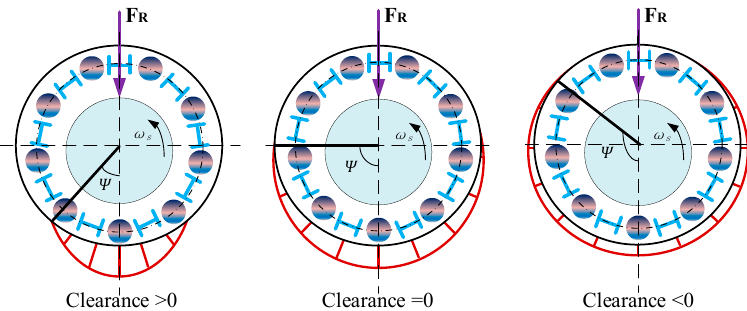
Figure 2. Rolling element load distribution for different amounts of clearances.